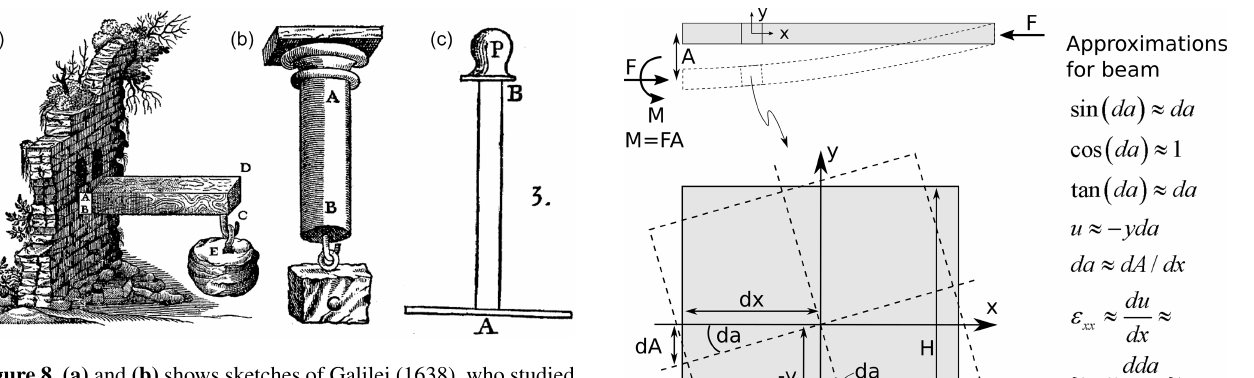
Figure 8. (a) and (b) shows sketches of Galilei (1638), who studied the strength of beams under beam-orthogonal loading (a) and the tensile strength of columns (b) . (c) shows a sketch of Euler (1744), who studied the so-called elastic curves (elastica) and the critical load for buckling of loaded columns.